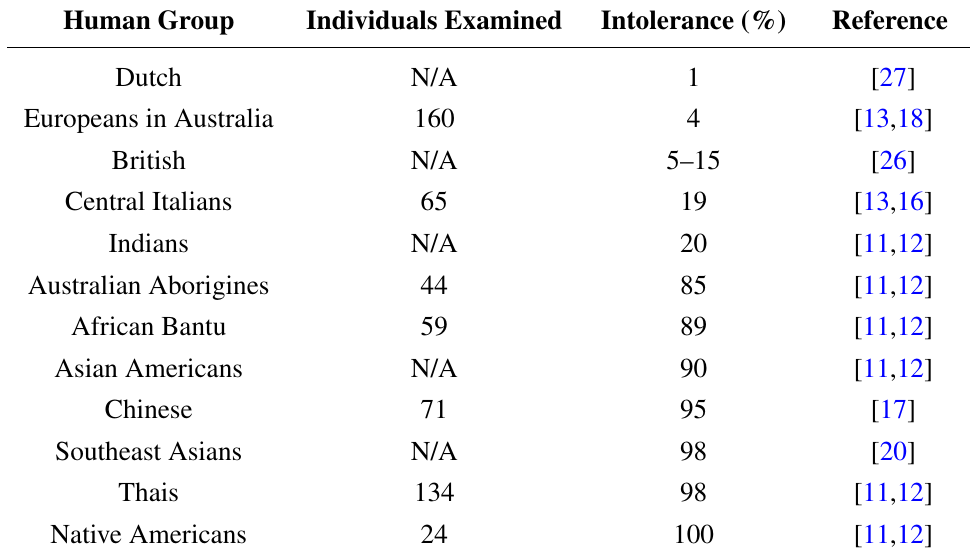
Table 3. Lactose intolerance in different human groups. Human Group